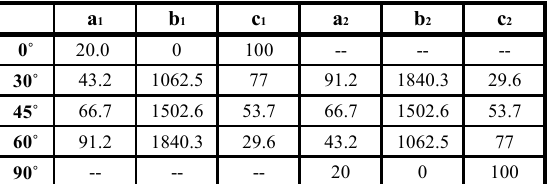
Table 1. Parameters of the first catenary curve (marked with * in Figure